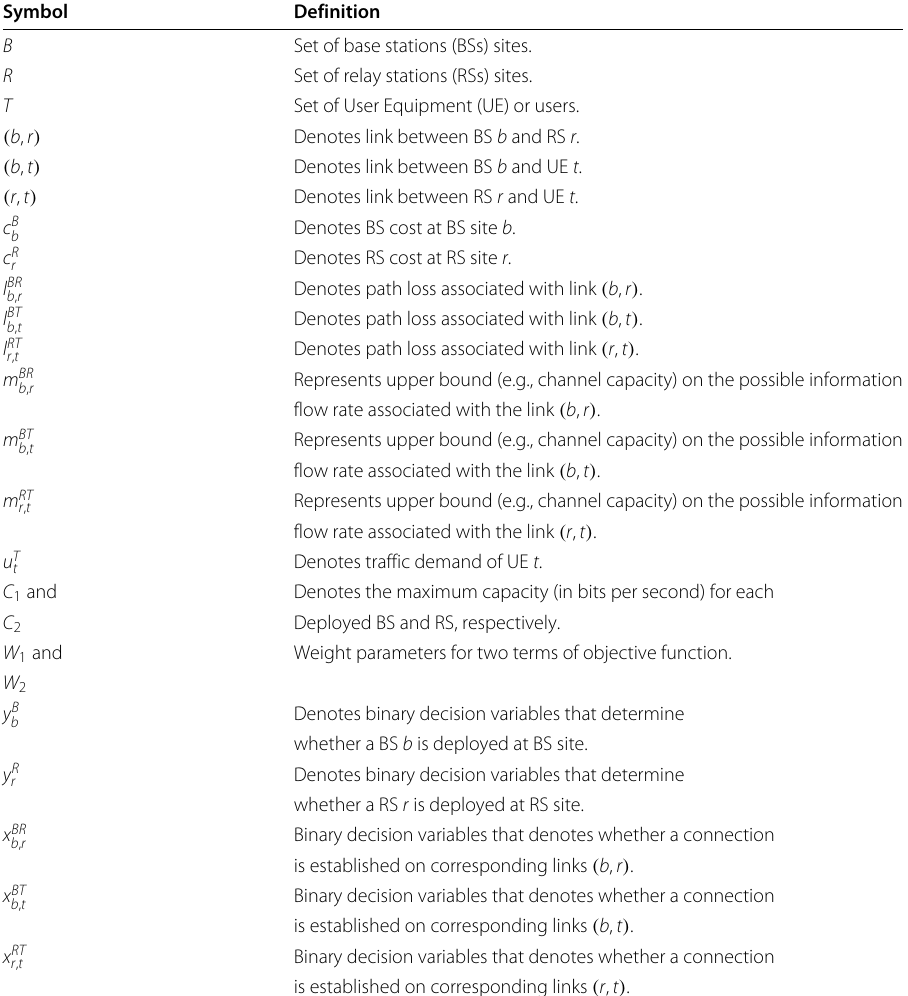
Table 1 Notations used in 5G and beyond wireless network